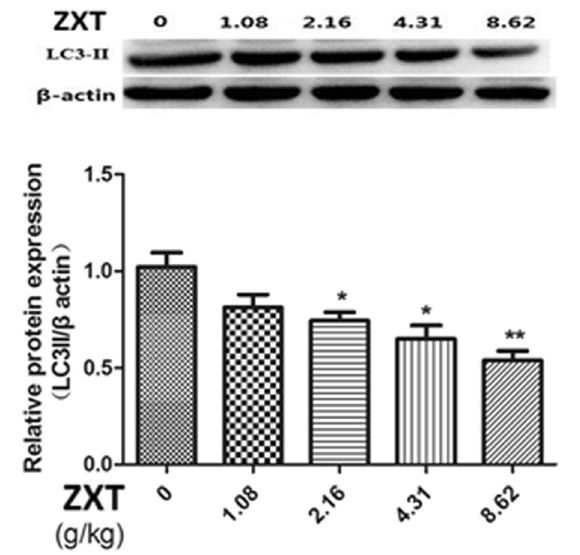
Fig. 6 Immunoblotting assays show that the Alisma and Rhizoma decoction caused a dose-dependent decrease in LC3-IIin hepatic tissues. * P < 0.05, ** P <